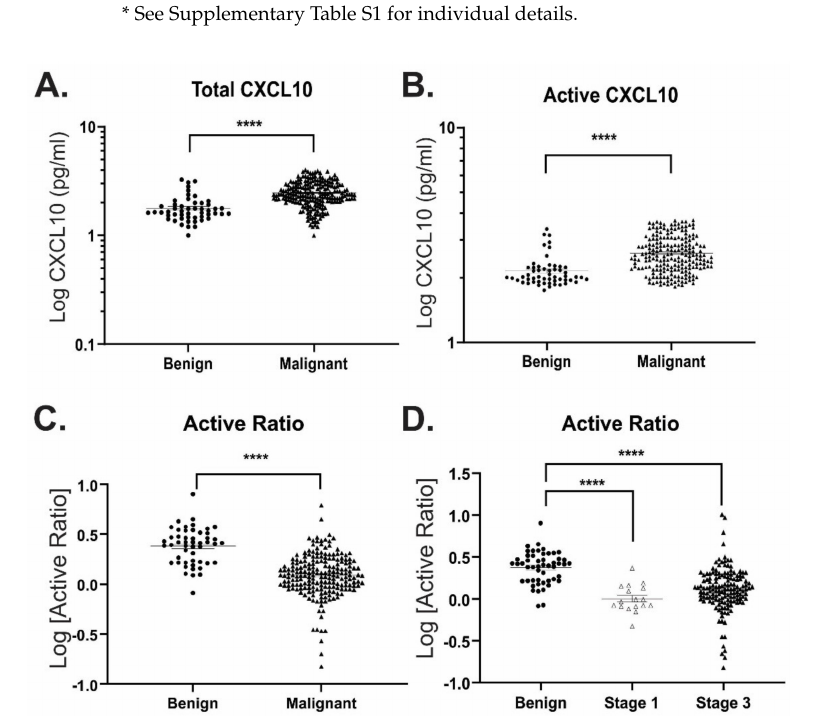
Figure 4. ART differentiates between benign and malignant disease in ascites fluid from ovarian cancer patients. ( A ) Total and ( B ) active CXCL10 concentrations measured in benign ( n = 51) and malignant ( n = 212) ascites fluid samples. ( C , D ) Calculated active ratio between ( C ) benign and all malignant samples; or ( D ) benign and cancer samples separated according to FIGO disease stage. **** p ≤